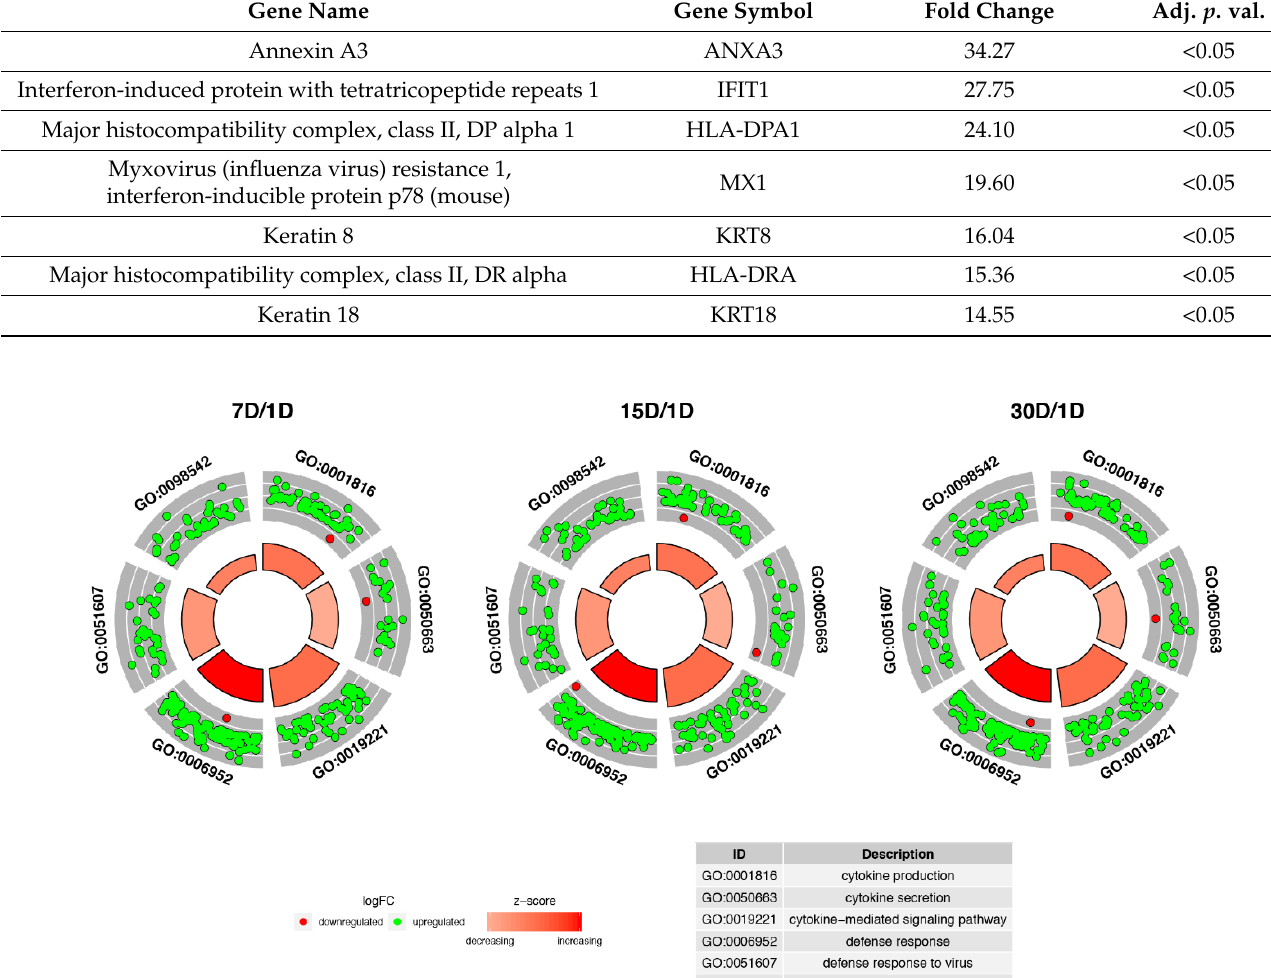
Table 2. The seven most upregulated genes involved in cytokine action and metabolism-mediated signaling pathways activity during immunological defense processes in human cumulus-oophorus cells (CCs). Fold change refers to the Day 7–Day 1 comparison.